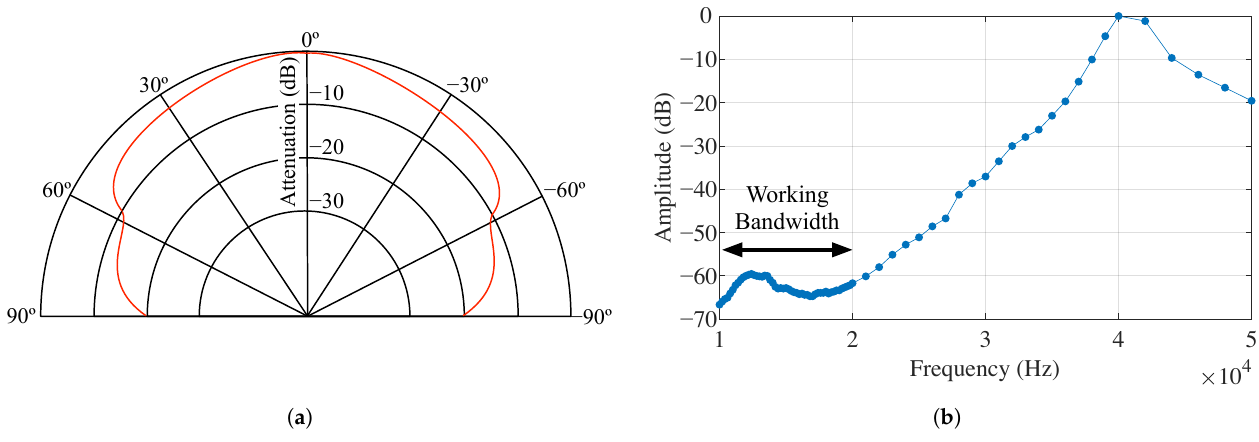
Figure 2. Acoustictransducerfeatures. ( a )Acoustictransducerdirectivitypattern[49]. ( b )Acoustictransducerfrequency